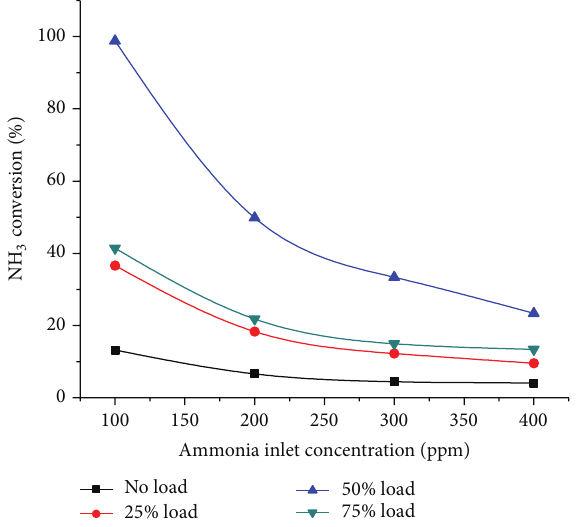
Figure 9: NH 3 conversion versus ammonia inlet concentration.